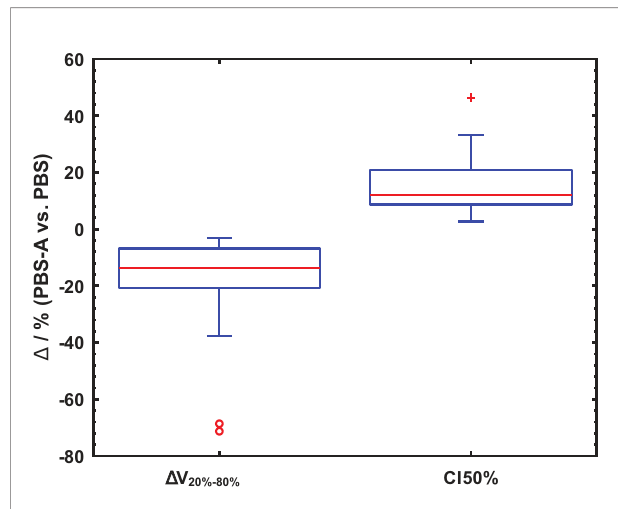
FIGURE 2 | Percentage difference of D V 20-80% and CI 50% between PBS plans with and without collimating apertures visualized in a box-whisker plot. D V 20-80% , volume between 20 and 80% isodose lines; CI 50%, conformity index of 50% isodose line; PBS, uncollimated pencil beam scanning; PBS-A, pencil beam scanning with apertures. The boxes (whisker) indicate the 25th and 75th percentiles (1.5 times interquartile range). Data points outside the three times (1.5 and three times) the interquartile range are indicated by open circles (plus symbol). Median values are indicated by red